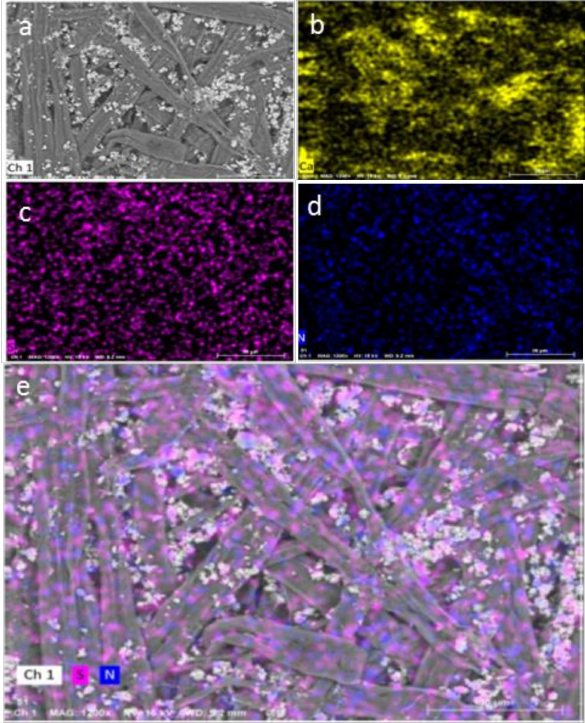
Figure 10. SEM ( a ) and SEM/EDS images ( b – e ) of industrial printing paper dual-step surface coated with LS and CL (LS + CL). The mapping images show the distribution of Ca from CaCO 3 (( b ), yellow color), S from LS (( c ), violet color), N from CL (( d ), blue color) and the combined image of S and N distribution ( e